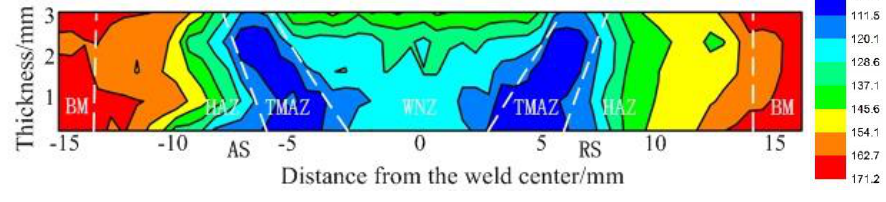
Figure 6. Hardness distribution of FSW joint.